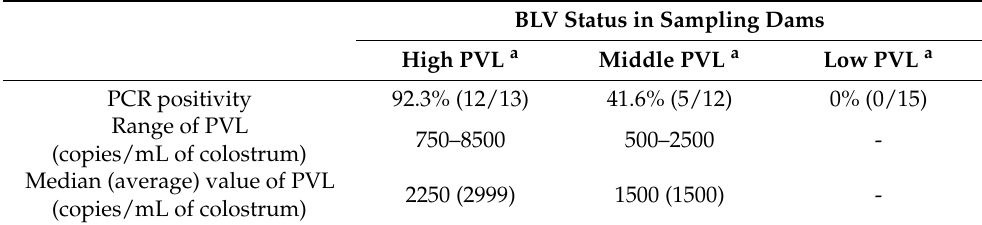
Table 1. Positivity and proviral loads (PVLs) of bovine leukemia virus (BLV) in colostrum.